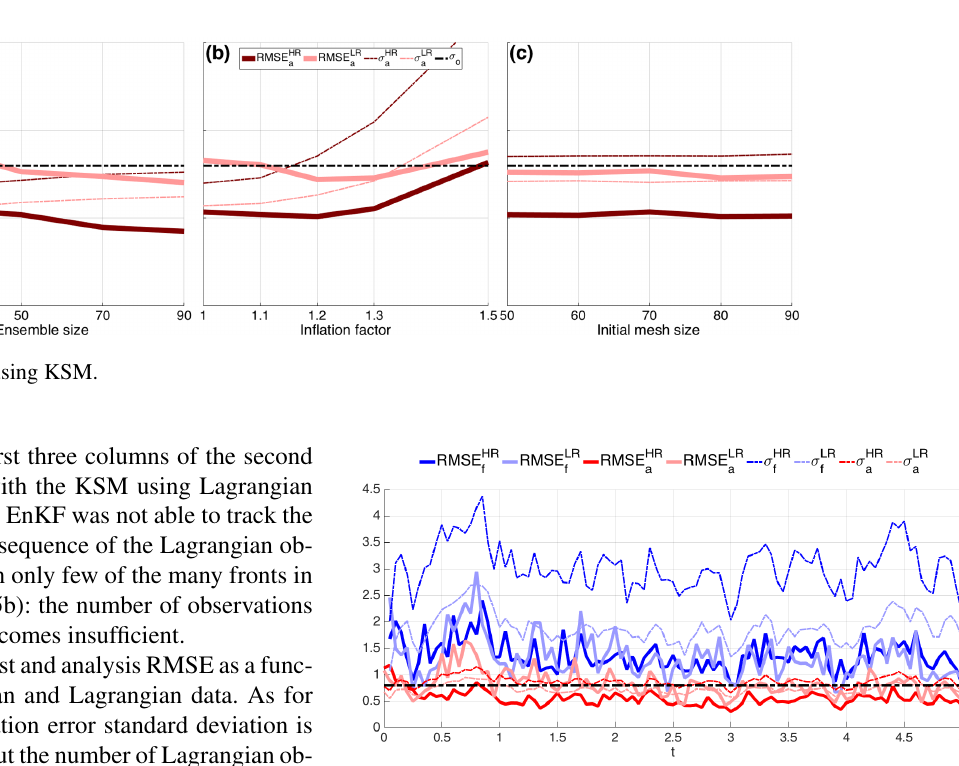
Figure 12. Same as Fig. 9, but using KSM.